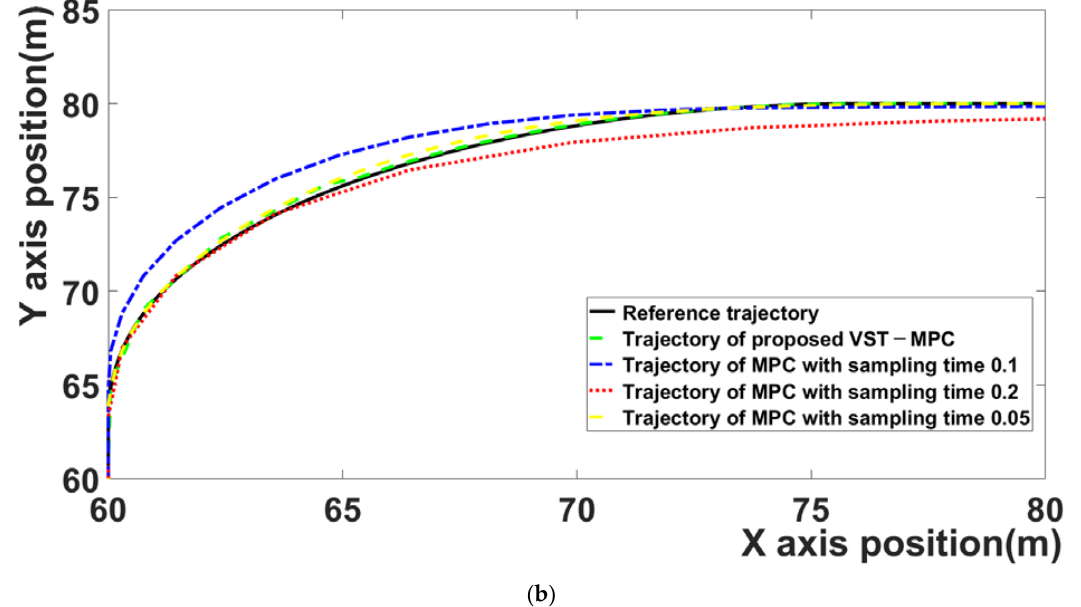
Figure 5. ( a ) The trajectory of section A, ( b ) the trajectory of section B. Table 2. Average tracking error and entire computation time of four MPC algorithms.